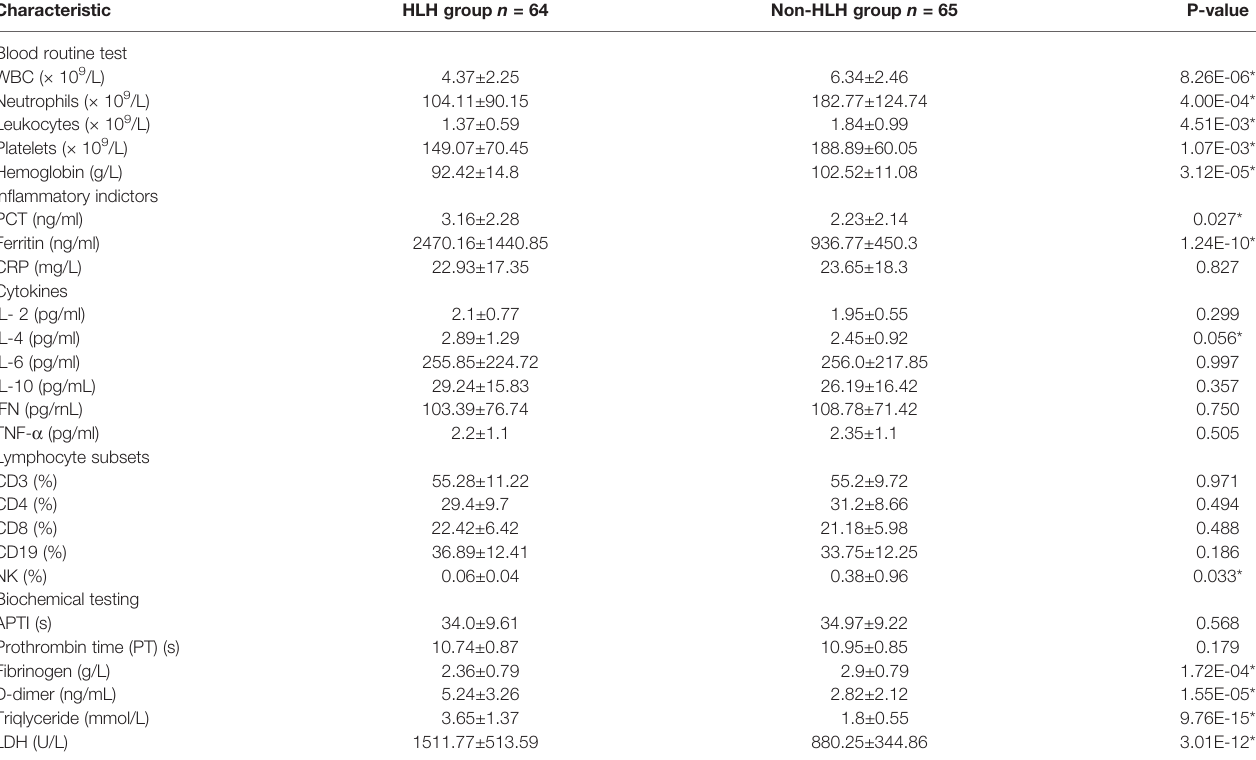
TABLE 2 | Clinical characteristics of HLH and non-HLH patient